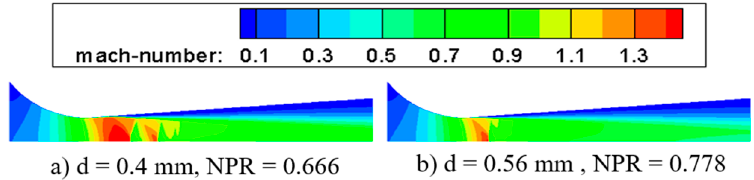
Figure 6. Mach number contours; ( a ) d = 0.4 mm, nozzle pressure ratio (NPR) = 0.666; ( b ) d = 0.56 mm, nozzle pressure ratio (NPR) = 0.778.